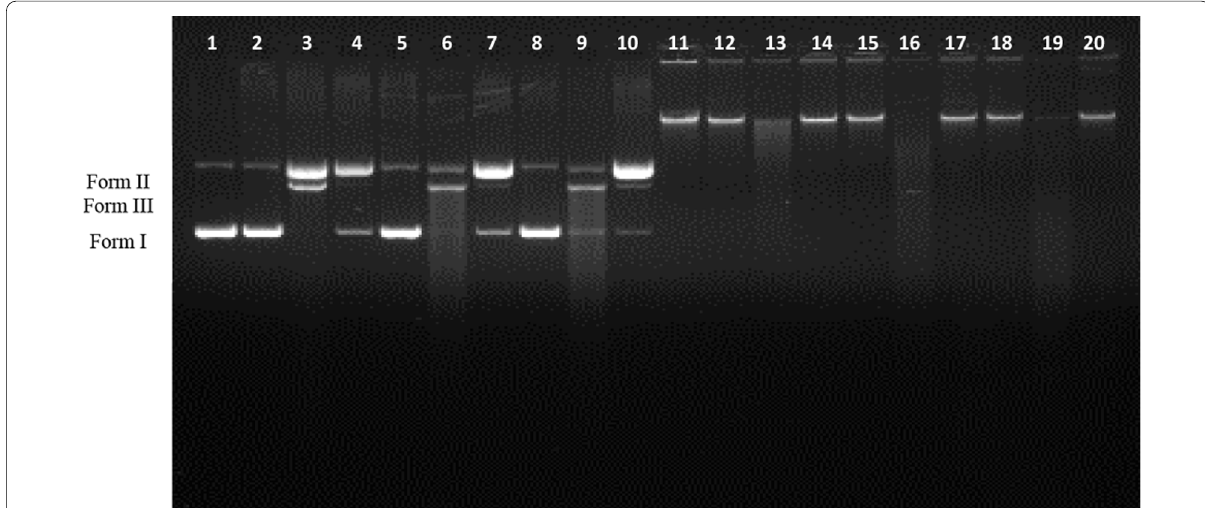
Fig. 11 Interaction of AgNPs with pBR322 DNA and λ DNA. Lane 1 3 pBR322 Fenton’s reagent (37 °C for 30 min.); Lane 4 = + Lane 5 pBR322 AgNPs (37 °C for 60 min.); Lane 6 = + 60 min.)) Fenton’s reagent (37 °C for 60 min.); Lane 8 + Lane 10 pBR322 AgNPs ((37 °C for 90 min.)) = + for 30 min.); Lane 13 λ DNA Fenton’s reagent (37 °C for 30 min.); Lane 14 = + 30 min.); Lane 15 λ DNA AgNPs (37 °C for 60 min.); Lane 16 = + 60 min.)) Fenton’s reagent (37 °C for 60 min.); Lane 18 + Lane 20 λ DNA AgNPs ((37 °C for 90 min.)) = +